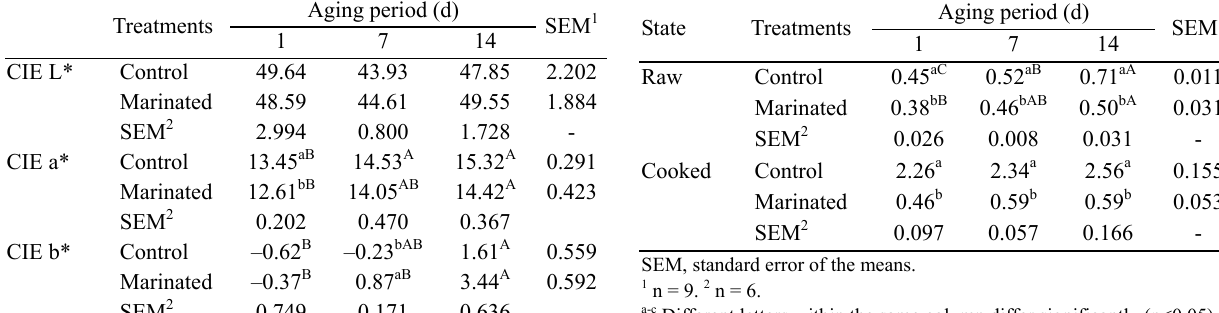
Table 3. Effect of aging and marination on color of duck breast meat Treatments